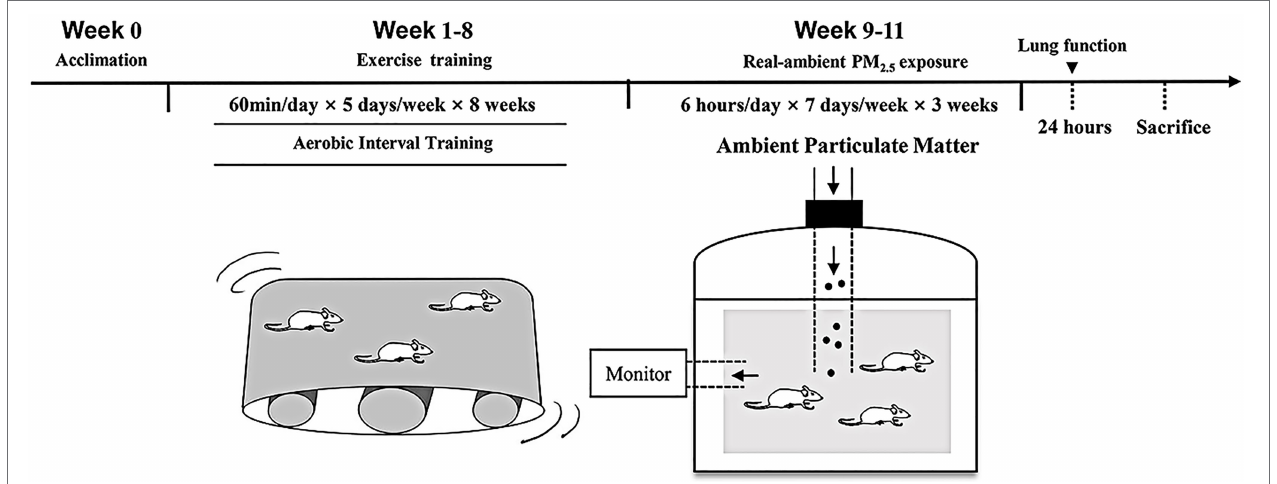
FIGURE 1 | Overview of the experimental